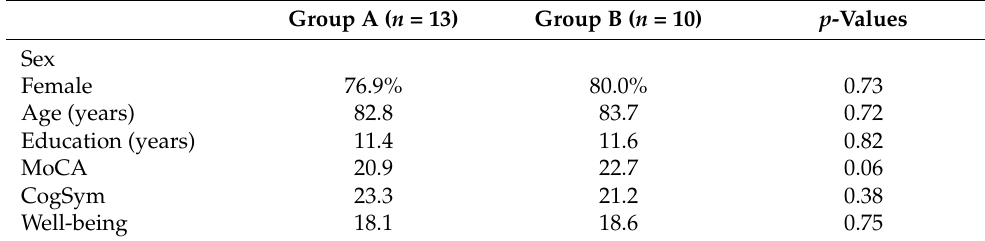
Table 1. Characteristics of the study